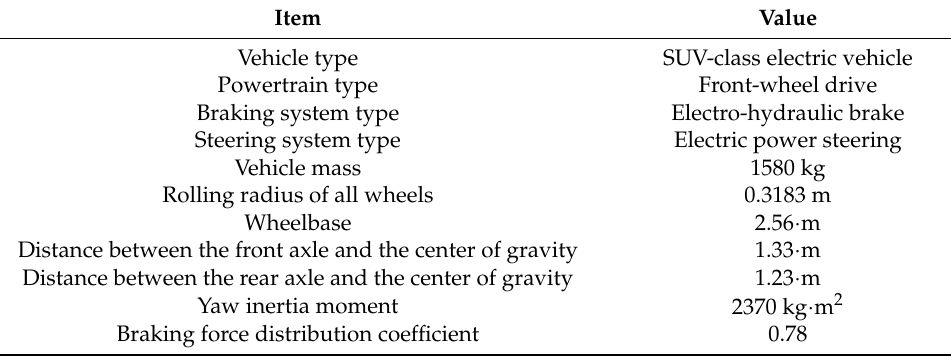
Figure 1. Picture of the test vehicle. Table 1. Configuration and parameters of the test vehicle.